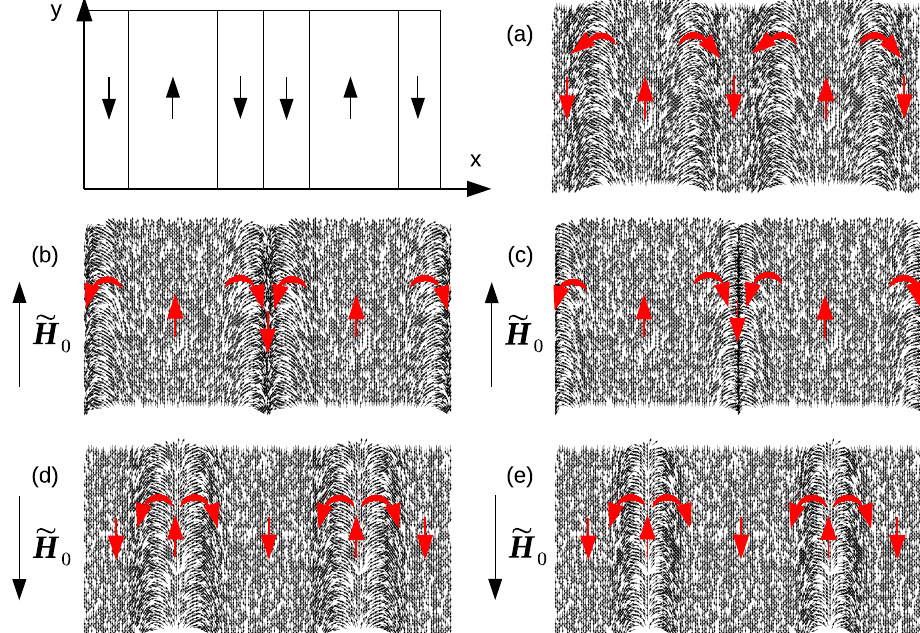
Figure 2. Distribution of the magnetization vector m in a magnetic field applied along the y axis: ( a )— ˜ H 0 = 0, ( b )— ˜ H 0 = 0.4, ( c )— ˜ H 0 = 2, ( d )— ˜ H 0 =